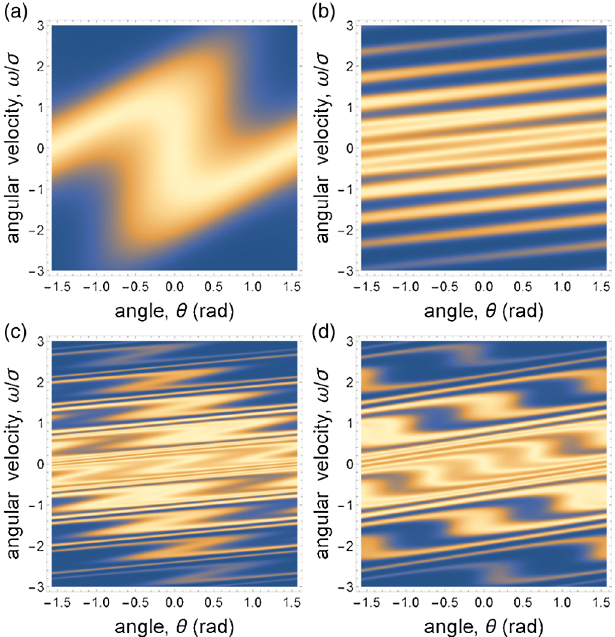
FIG. 2. Filamentation of the phase-space density distribution. For all parts of this figure, Ω 1 = σ ¼ 1 . (a) Shortly after the kick, σ t ¼ 0 . 5 , the density distribution folds, resulting in a transient alignment along the direction θ ¼ 0 . The folded pattern is centrally symmetric with respect to the phase-space point ð θ ; ω Þ ¼ ð 0 ; 0 Þ that is not affected by the kick. (b) On longer time scales, σ t ¼ 5 , the probability density becomes wrinkled, and it develops multiple parallel filaments. (c) After a second kick is applied at t ¼ T (with σ T ¼ 5 and Ω 2 = Ω 1 ¼ 1 = 3 ), every filament in (b) folds in a manner similar to (a), giving rise to an alignment echo near θ ¼ 0 at time τ ∼ T after the second kick ( στ ¼ 4 . 56 ). (d) At τ ≈ T= 2 ( στ ¼ 2 . 293 ), a fractional echo is formed.